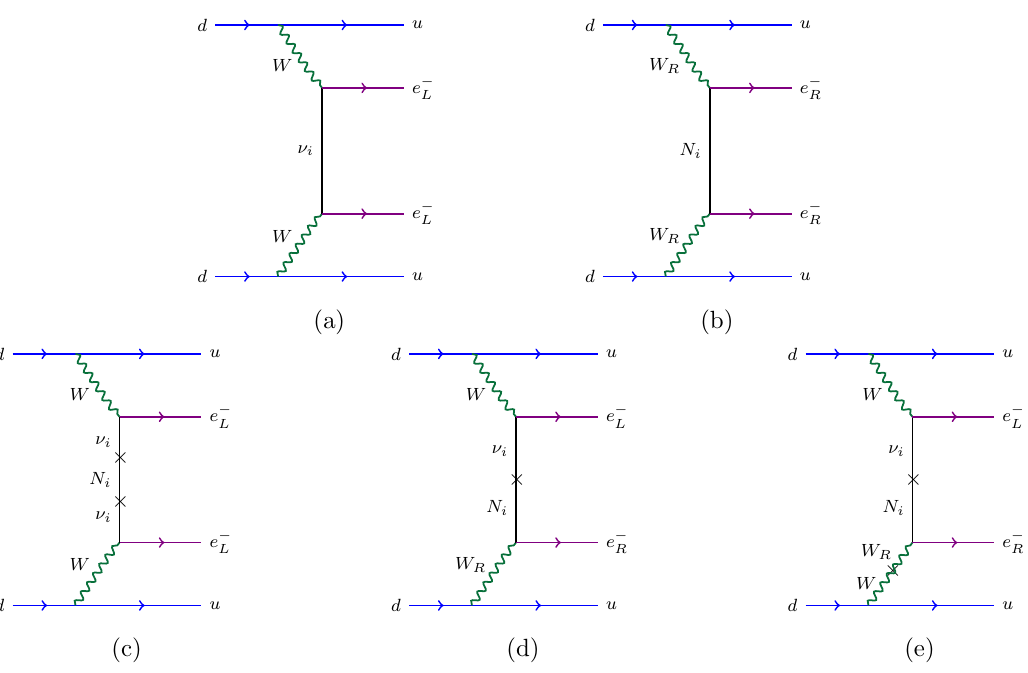
Figure 11. Feynman diagrams for relevant contributions to 0 (cid:23)(cid:12)(cid:12) decays in the LRSM with type-I seesaw dominance: (a) propagators denotes heavy-light neutrino mixing, and the in diagram (e) denotes the W